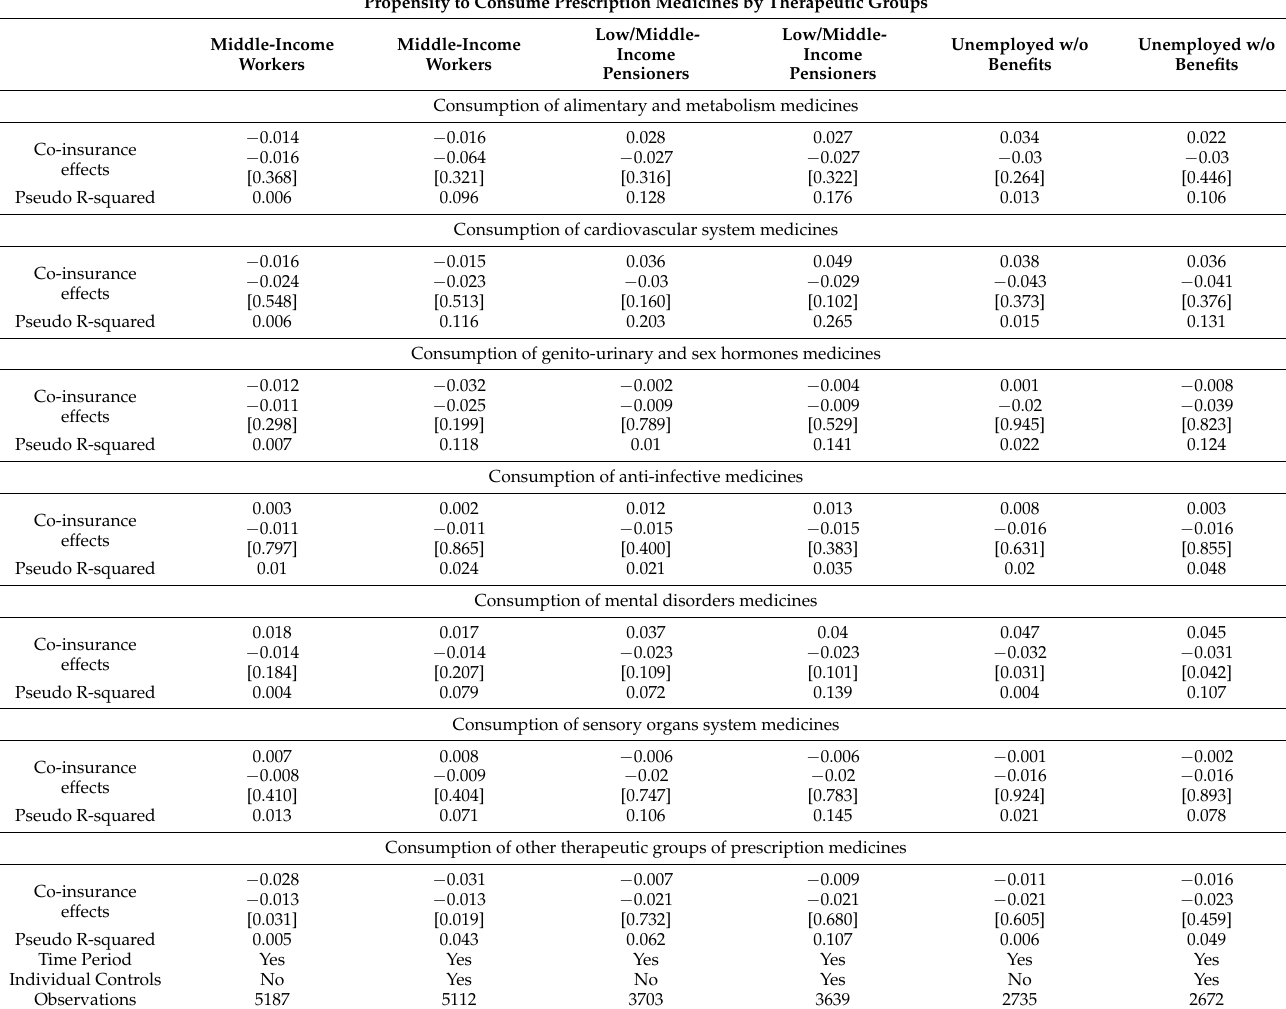
Table A3. Results for the propensity to consume therapeutic groups of prescription medicines using non-linear estimation method